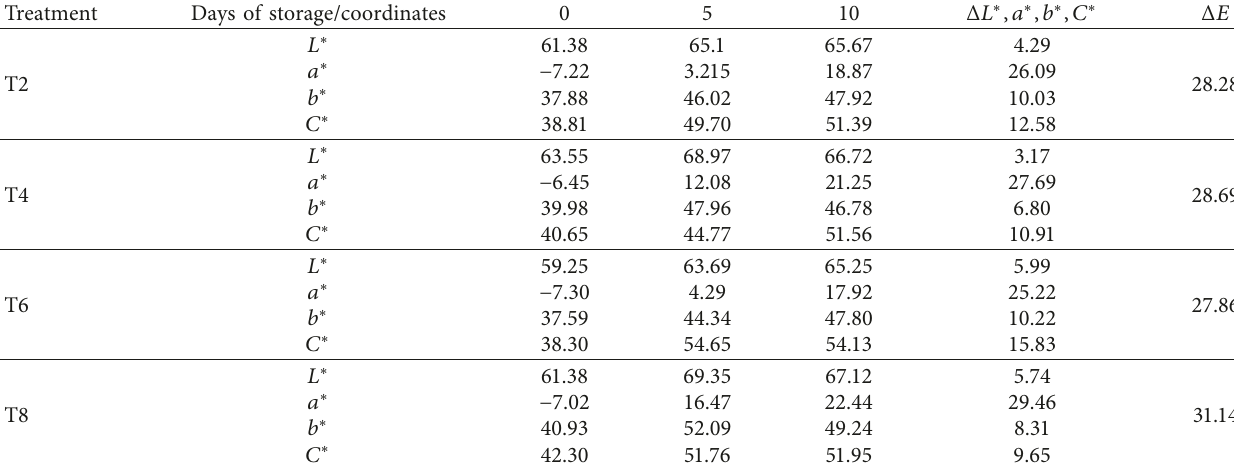
Table 3: Color evolution of fruits stored at 10 ± 2 ° C and HR > 80%. Stenospermocarpic mango “Ataulfo” coated with 2% starch. T1 (banana “Pear”), T3 (soursop), T5 (mango “Ataulfo”), and T7 (control fruit: uncoated).